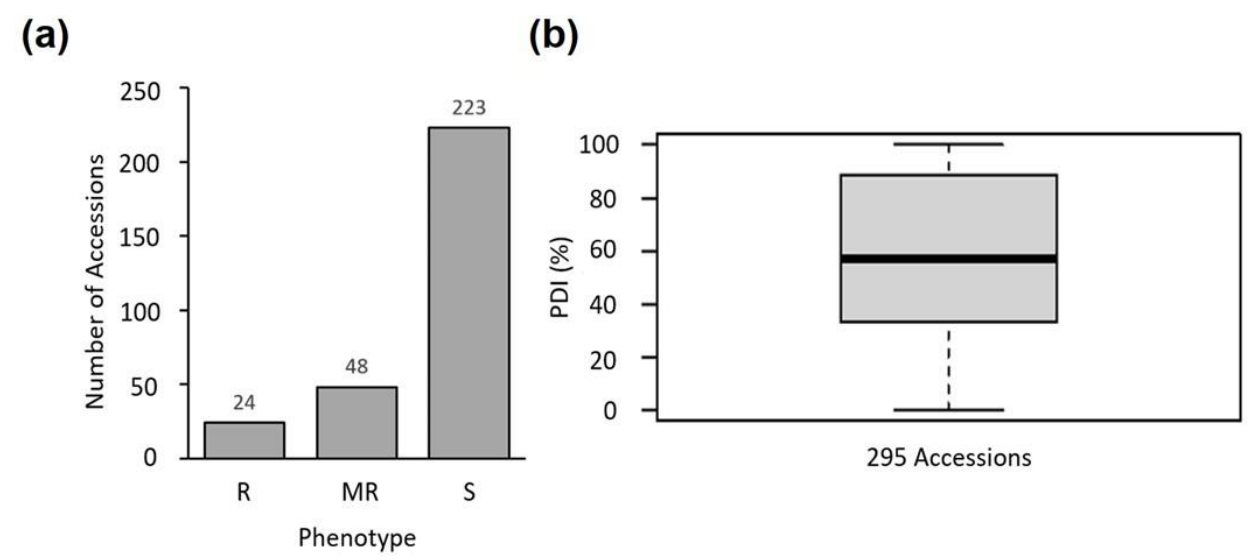
Figure 2. ( a ) Phenotypic distribution of resistance to powdery mildew caused in tomato by Oidium neolycopersici ; ( b ) A box plot showing the statistics of distribution. In the box plot, the bold line in the middle of the gray box represents the median (cumulative percentage 50% = 57.14%), while the upper and lower edges of the box represent the cumulative percentage 75% = 88.89% and 25% = 33.33%, respectively.